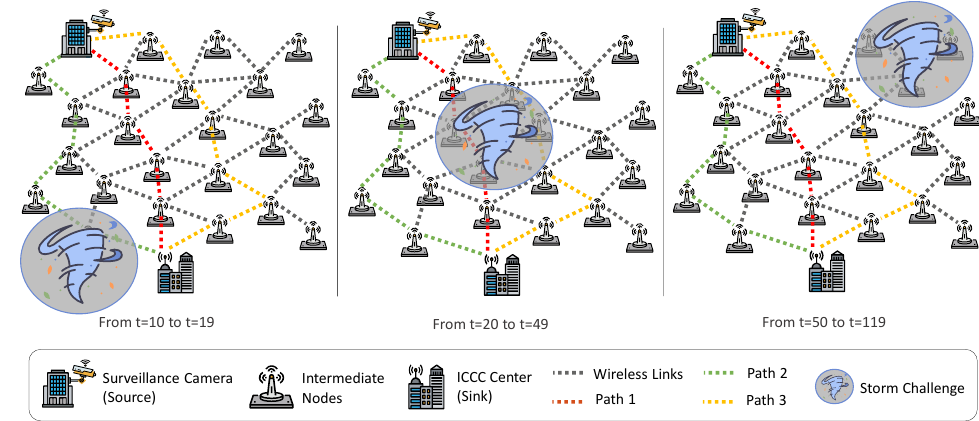
Figure 10. Storm challenge